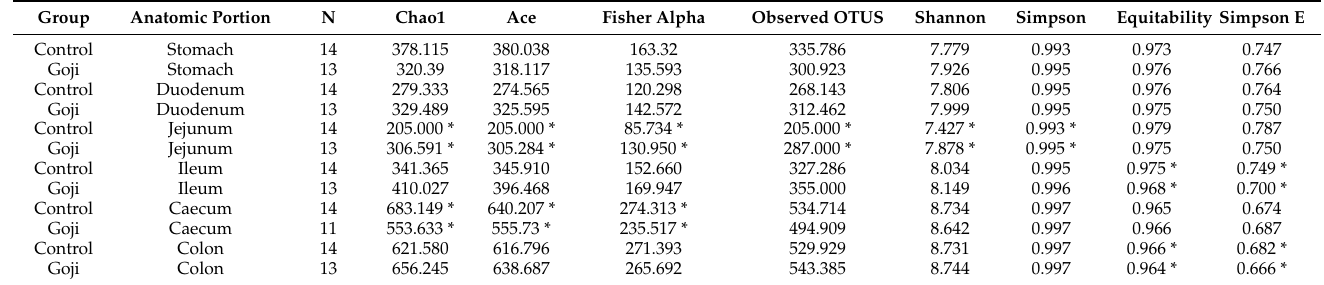
Figure 4. Distribution of the F:B ratio (Firmicutes to Bacteroidetes) in control and Goji-treated groups along the gastrointestinal tract. For the analyses, 14 and 13 samples were used for the control and Goji groups, respectively. Table 2. Alpha diversity indices along the digestive tract of rabbits in the two experimental groups (14 controls and 13 Goji-treated; two more samples, both from caecum intestinal G diet were removed because they had a total number of read counts < 100). * indicates significant difference ( p < 0.05) between control and Goji